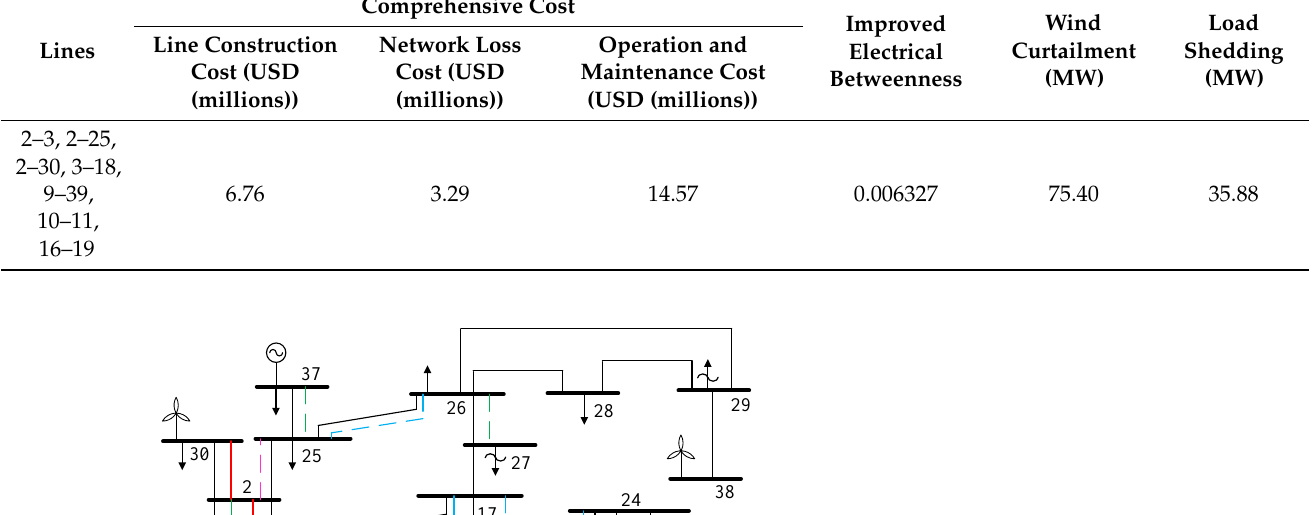
Table 15. TNEP scheme of B&B in modified New England 39-bus system.